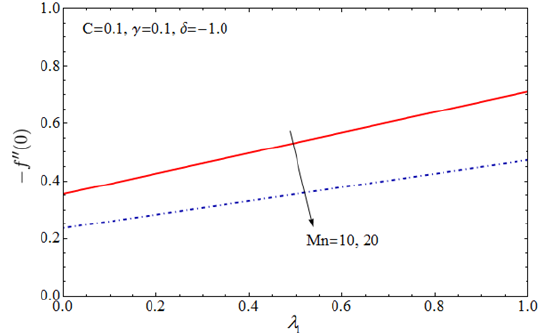
Fig. 9 Dimensionless skin friction coefficient − f (cid:48)(cid:48) ( 0 ) versus γ for different values of C .